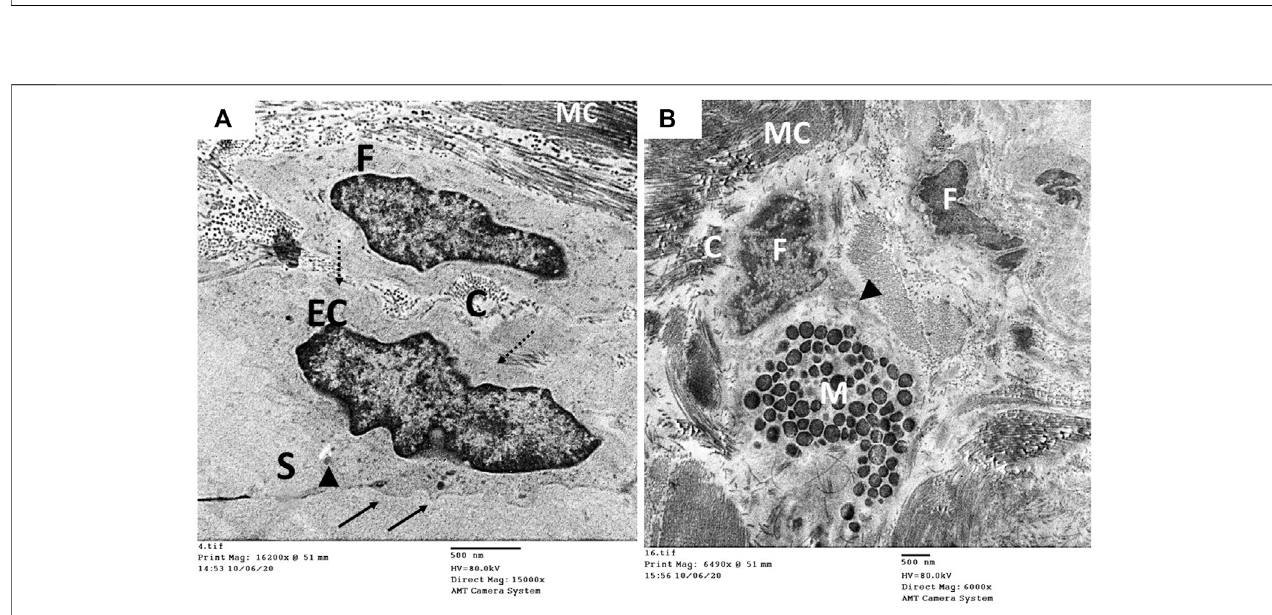
FIGURE12| Transmission electron microscopicpicturesoftheCC ofdiabeticUSC-treated group (group III)showing (A) oneofthecavernousspaces(S)lined with endothelial cell (EC) with slightly irregular luminal surface (arrow) and moderately thickened basal lamina (dashed arrow). Few pinocytic vesicles (arrowhead) were found in its cytoplasm. One fi broblast (F) and few immature collagen fi bers (C) are seen surrounding the space. (B) Active fi broblast (F) with cytoplasmic processes (arrowhead) surrounded by many mature collagen fi bers (MC) and few immature ones (C). Mast cells (M) were noticed in several specimens of this